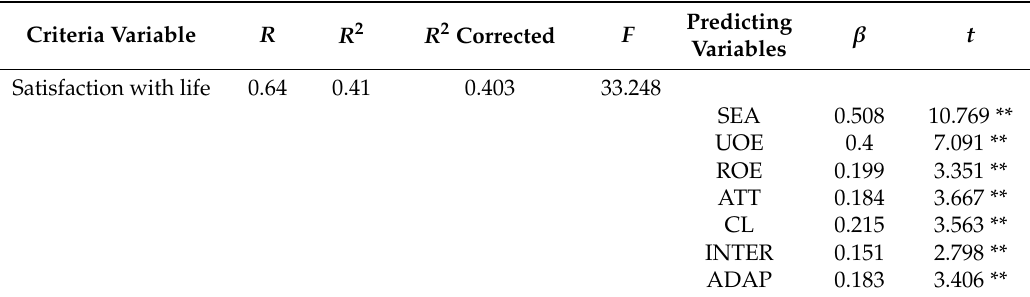
Table 4. Multilevel regression analysis, criteria variable: life